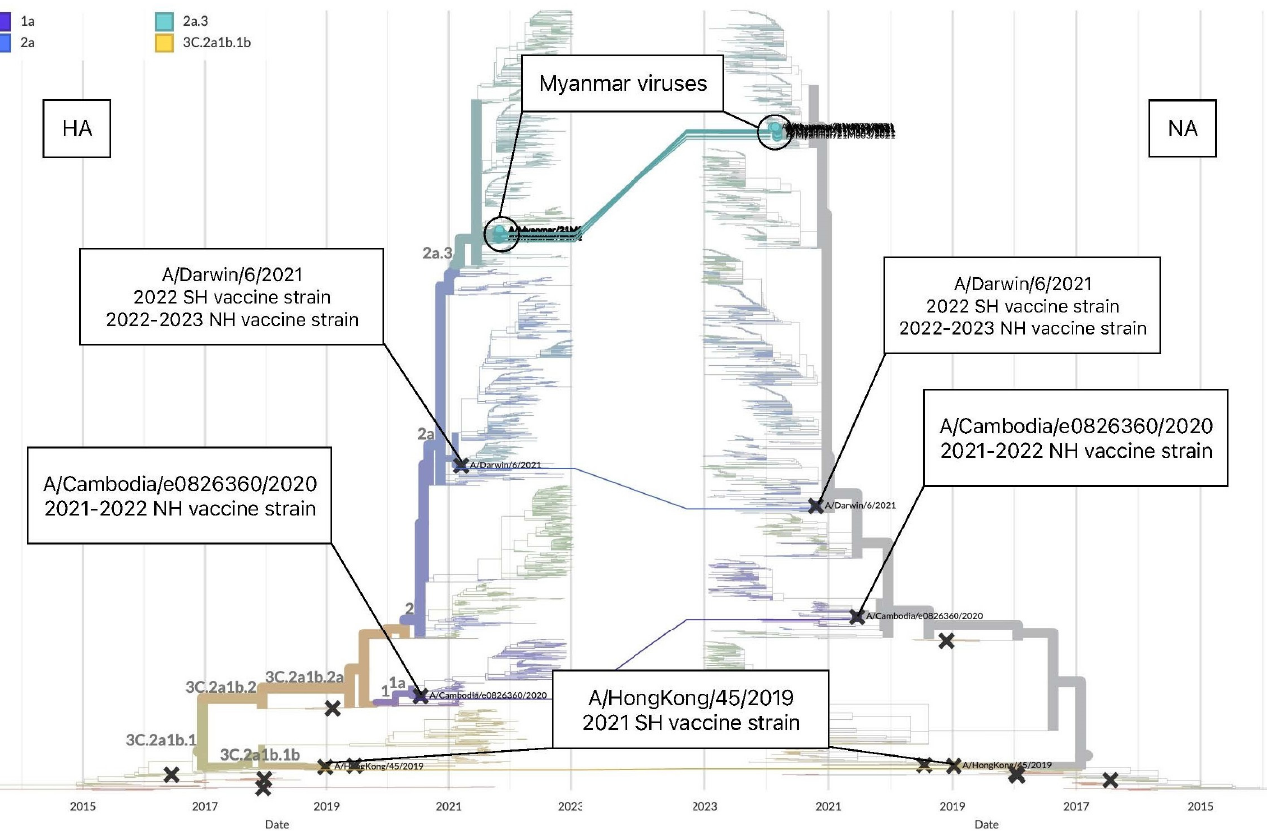
Figure 3. Tanglegram of the HA and NA segments of the influenza A(H3N2) viruses with a time scale of 2 years displayed by Nextstrain (accessed on 17 February 2023) [27]. Comparative topology between the HA and NA segments for influenza A(H3N2) viruses collected in Myanmar during this study and vaccine strains of the 2021 and 2022 seasons.